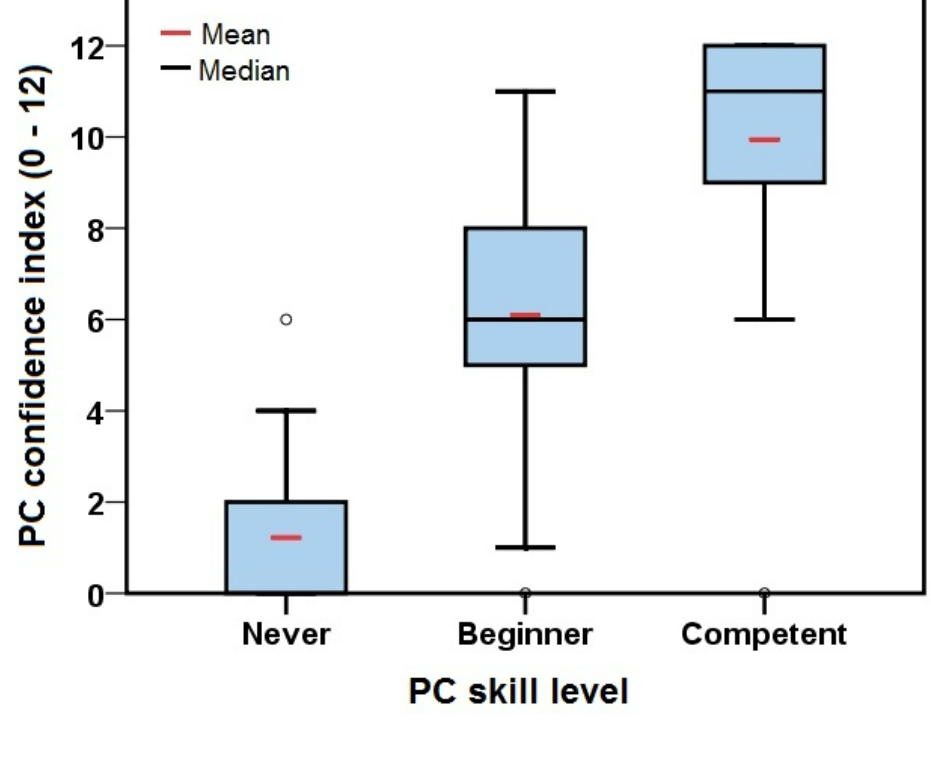
Figure 1. Mean and median PC confidence index by PC skill level for computer confidence questionnaire respondents